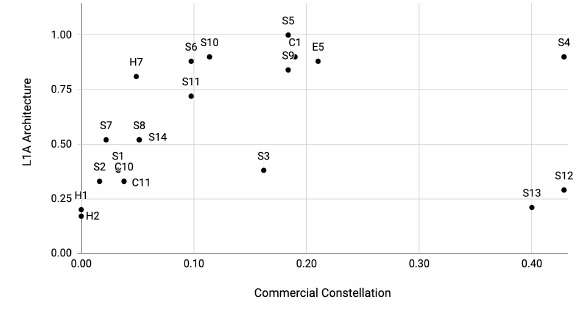
Figure 2 . Commercial assessment scores against L1A architecture for GOs with performance tool based